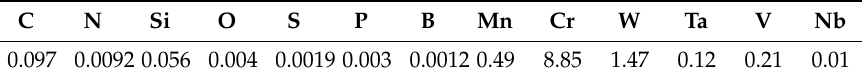
Table 1. Chemical composition of China low activation martensitic (CLAM) steel (in wt %). C N